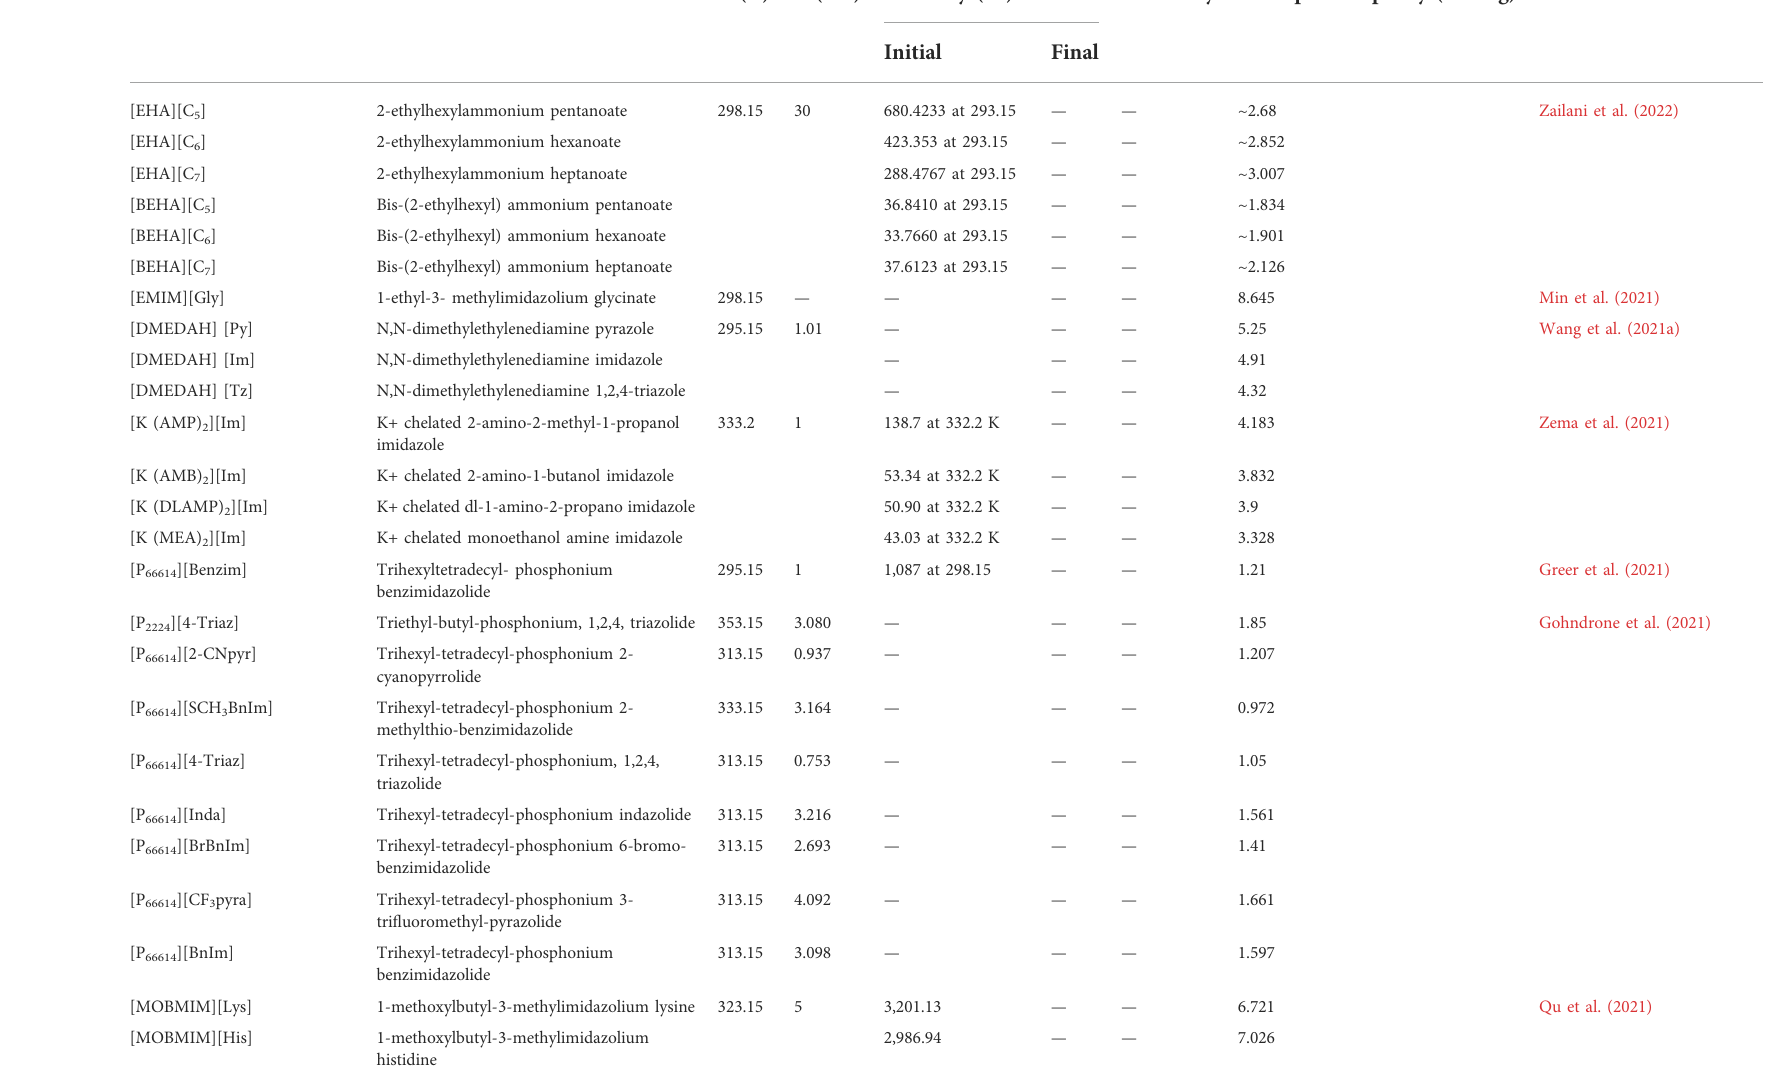
TABLE 2 Chemical-based ILs reported in 2021 –